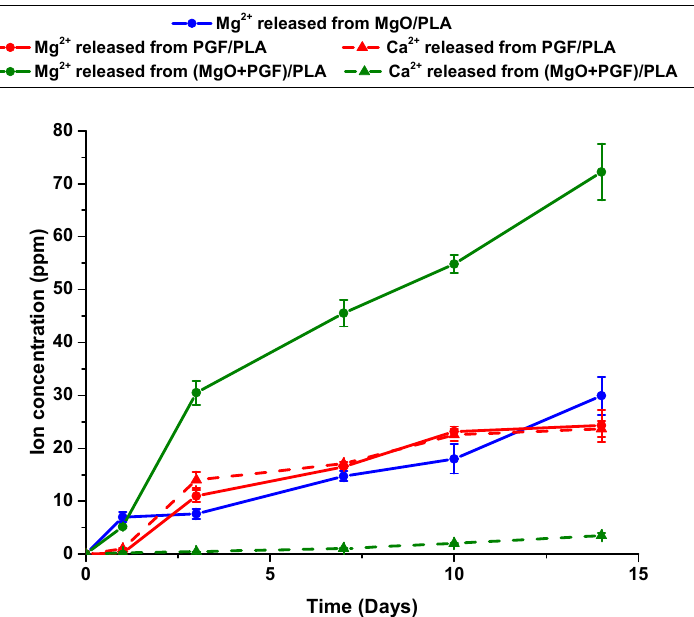
Figure 12. Ion concentration profile in the degradation media immersed with different scaffolds.